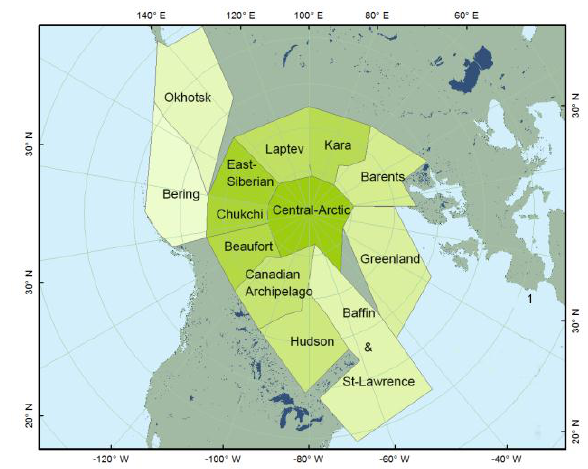
Figure 4. Distribution of 13 regions in Arctic